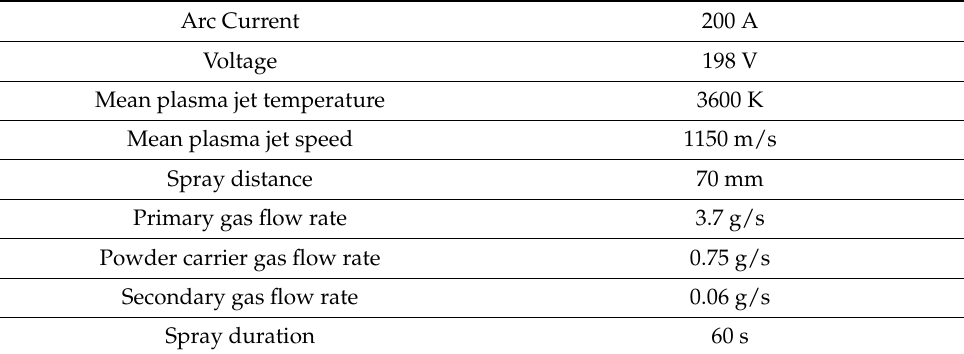
Table 1. Plasma spraying conditions for deposition of the ceramic coatings.